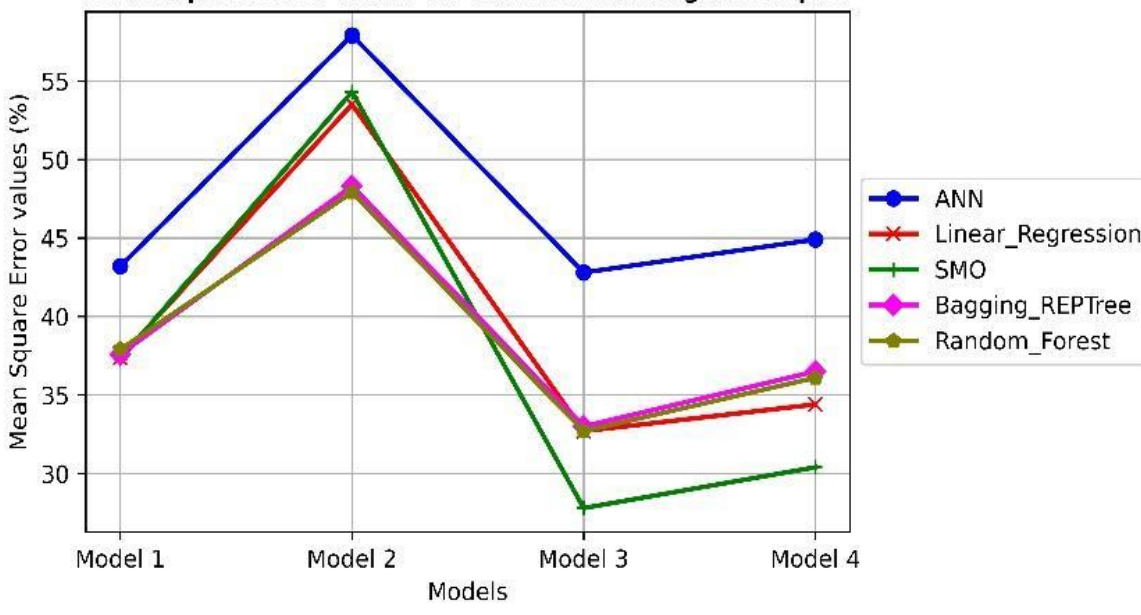
Figure 3. The results of using ML techniques on SANAD App